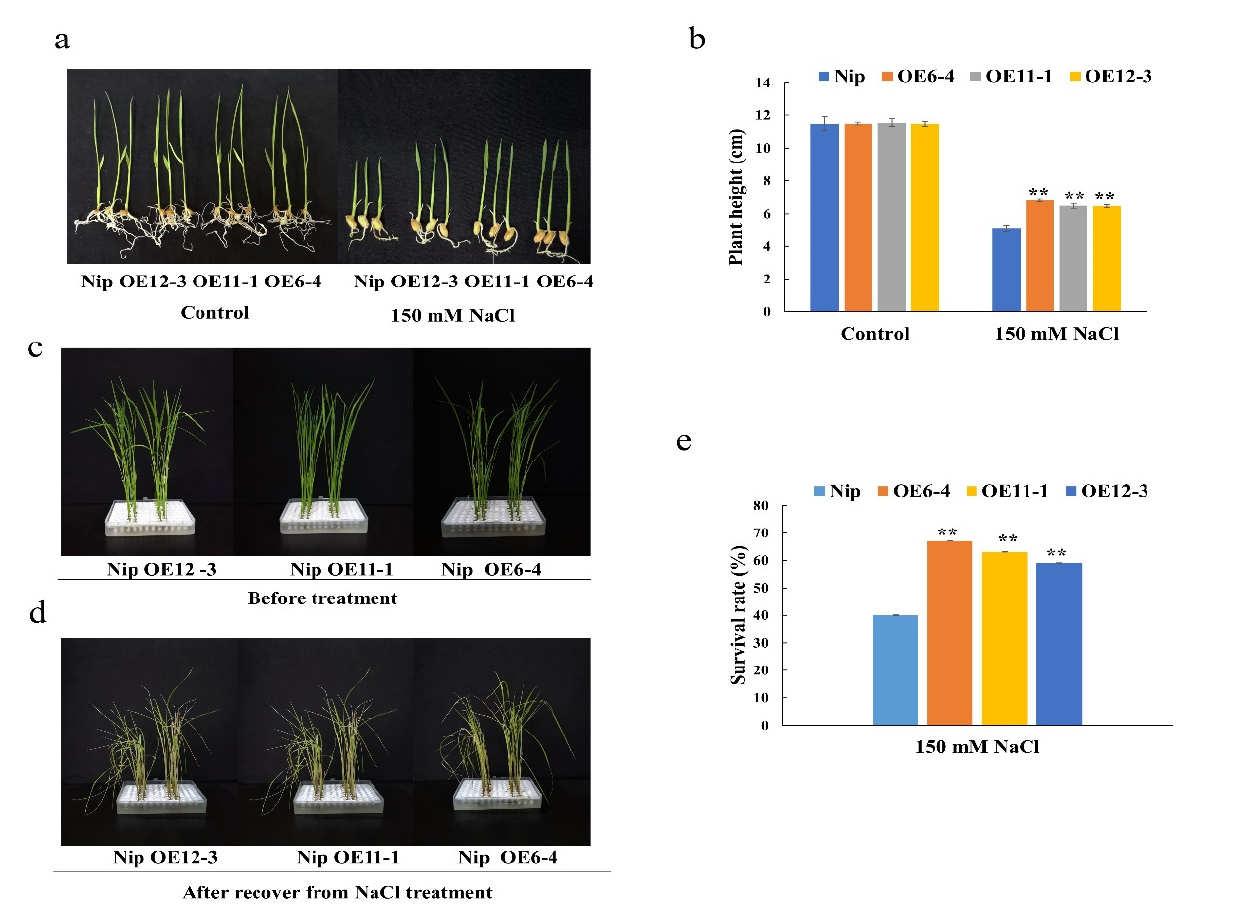
Figure 5. Salt stress treatment of OsMLP423 transgenic lines. ( a ) OsMLP423 transgenic plants after 150 mM NaCl for 7 days. ( b ) Relative plant heights. ( c , d ) Phenotypic differences in OsMLP423 overexpression and wild-type recovery after 150 mM NaCl treatment. ( e ) Survival rate. Values are mean ± SE ( n = 3). Asterisks indicate significant differences between transgenic lines and WT (** p < 0.01). n = 20 plants per treatment.